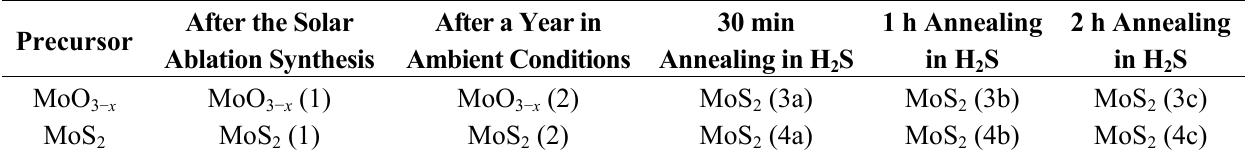
Table 1. The samples labeling that were used during the experimental work. Precursor